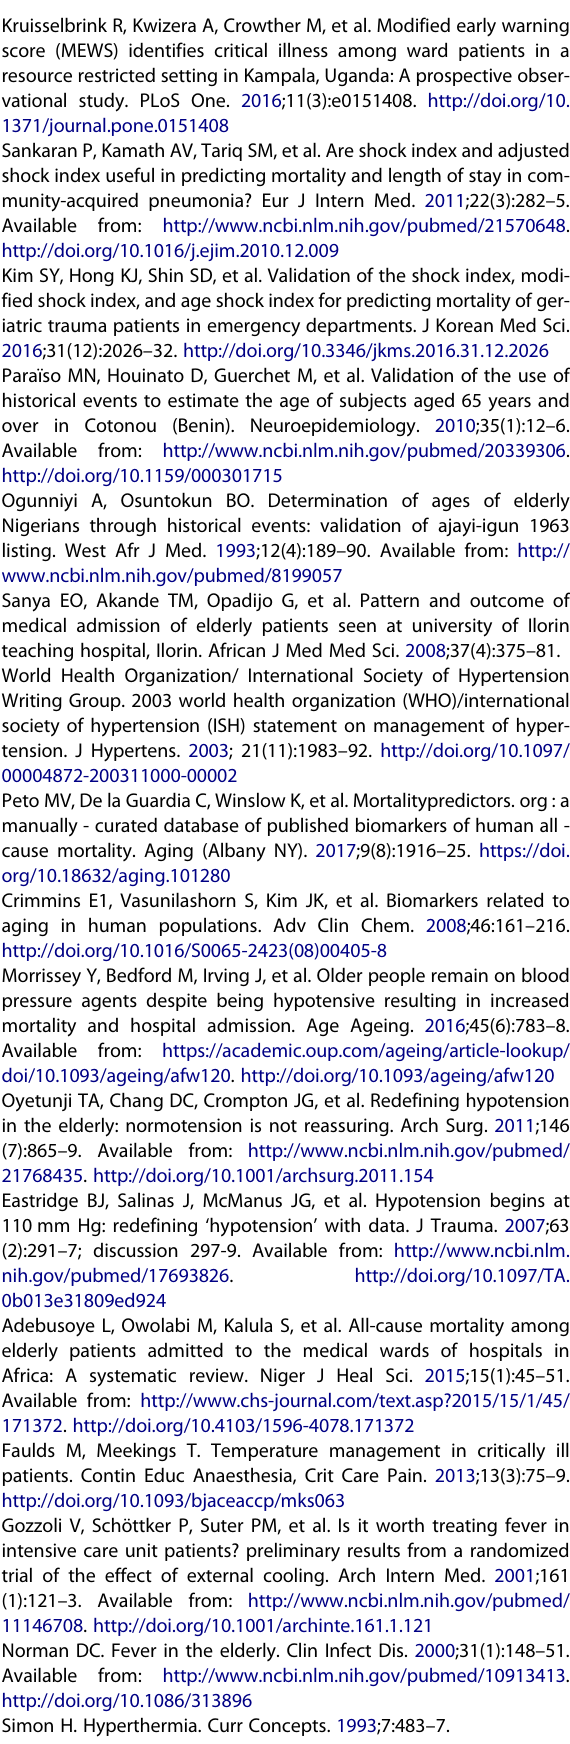
Table 4: Multiple Cox regression model of all-cause mortality and biomarkers Factor Β p -value Temperature ( ≥